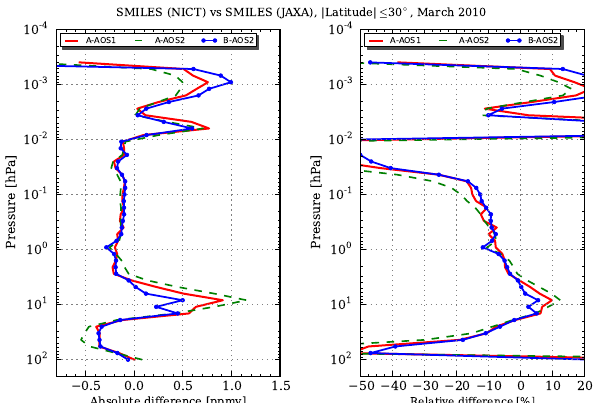
Fig. 8. Difference profiles of O 3 : SMILES(NICT)–SMILES(JAXA) for each band and AOS configuration, from March 2010 observa- Fig. 8. Comparison between SMILES(NICT) and SMILES(JAXA) tions. Absolute and relative differences are shown in the left and O 3 products, for each band and AOS configuration, from March right panels, 2010 observations. Absolute and relative differences are shown in the left and right panels, respectively.